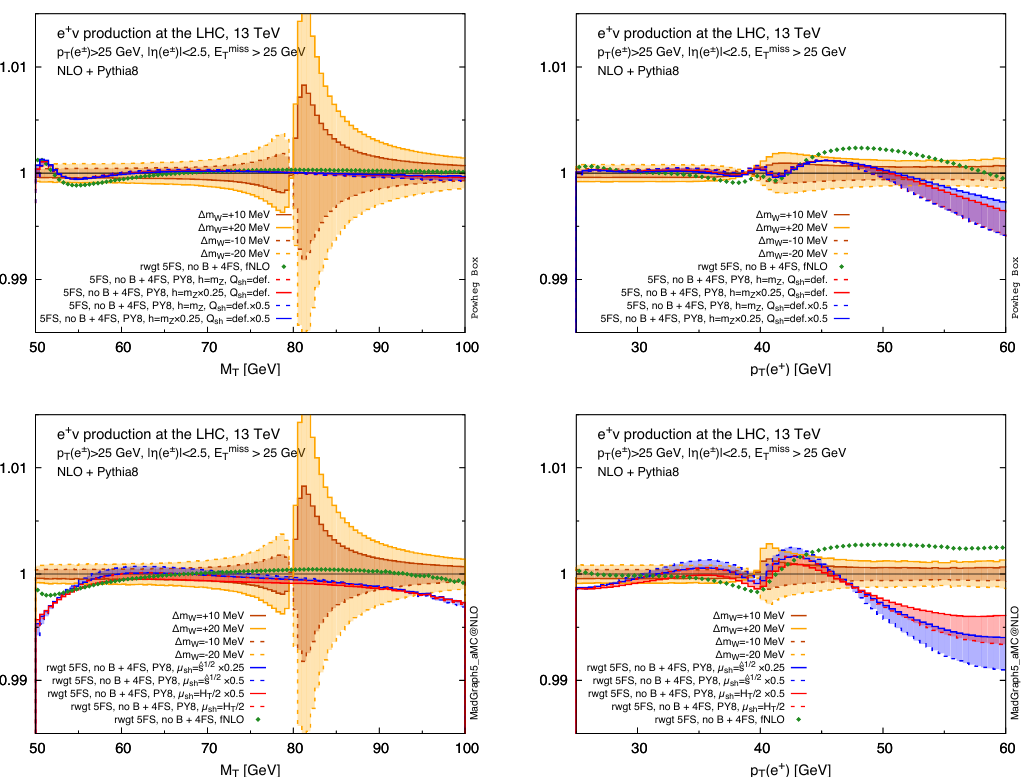
Figure 13 . Comparison of templates generated for di(cid:11)erent m (orange shaded areas). In the top row we show the POWHEG-BOX results, while in the bottom row we present the equivalent curves from MG5 aMC . In blue, red and green we display the curves obtained by using the reweighting function R , for several di(cid:11)erent